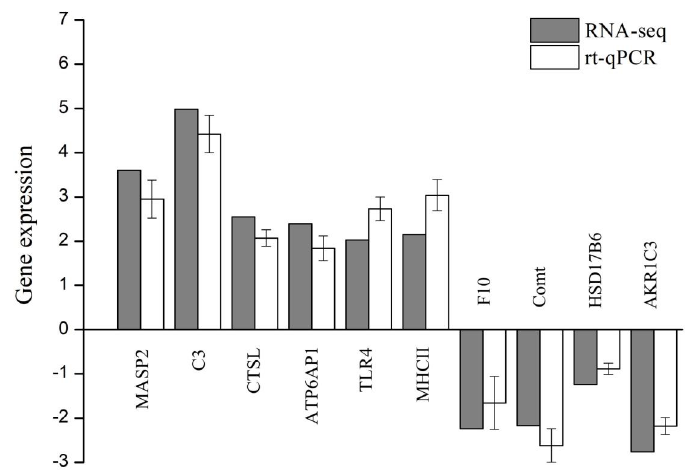
Figure 5. Validation of ten DEGs by real-time quantitative PCR. X -axis: gene name, Y -axis: the relative expression level is expressed as log2 (fold change) in gene expression. The relative expression of ten random genes was determined by real-time qPCR (white column) and compared with the results of RNA-seq (grey column). Error bars represent standard deviation ( n =